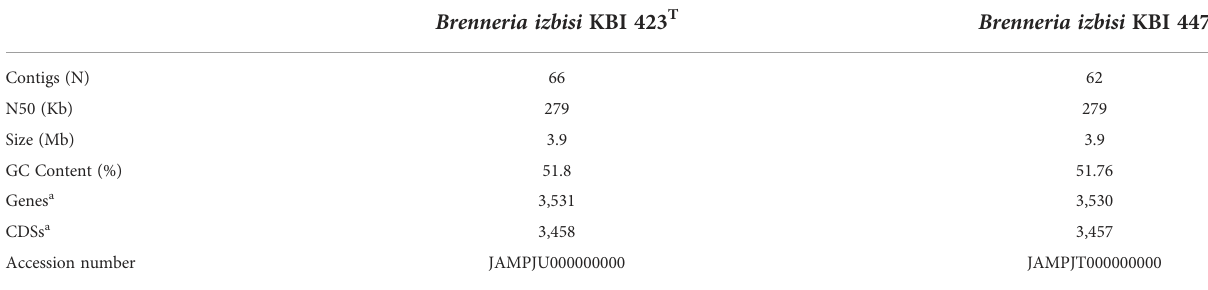
TABLE 3 General features of genome sequences obtained in this study.